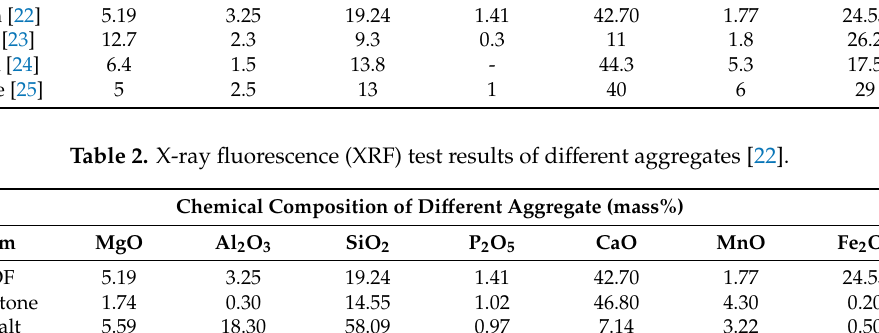
Table 1. Composition in %weight of basic oxygen furnace (BOF)-Steel obtained from di ff erent countries. Country